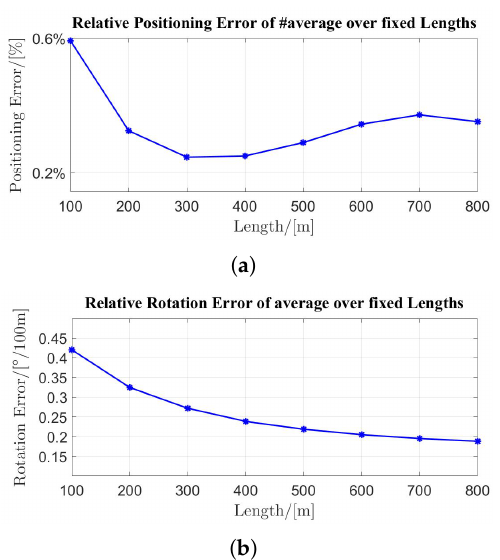
Figure 12. The average RTE and RRE of InTEn-LOAM over fixed lengths. ( a ) RTE; ( b )